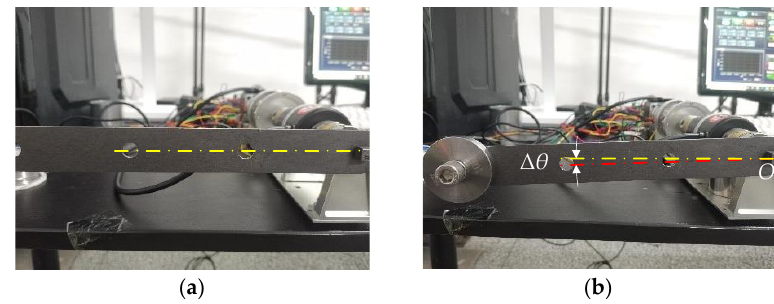
Figure 19. Static loading diagram. ( a ) Preloading; ( b ) after loading.